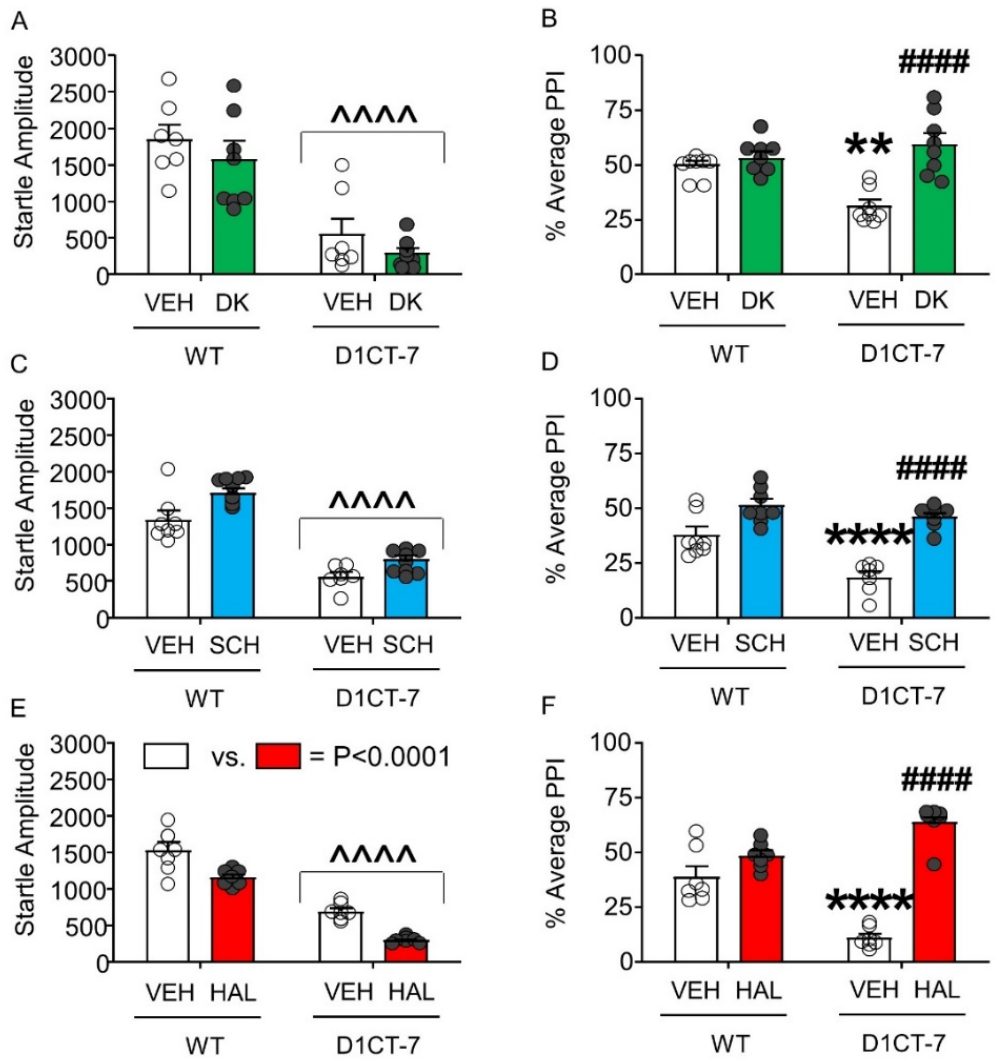
Figure 6. Effects of DK-I-56-1 (DK, 10 mg/kg, IP) and dopaminergic antagonists on tic-like responses in D1CT-7 and wild-type (WT) mice exposed to spatial confinement. ( A ) D1CT-7 mice had lower startle amplitude than WT littermates (Main effect of genotype: F(1,25) = 49.04, p < 0.0001), but this difference was not affected by DK. ( B ) DK reversed the PPI deficits observed in D1CT-7 mice, but not WT mice (Genotype × treatment interaction: F(1,25) = 12.37; p = 0.002). ( C ) The D1 receptor antagonist SCH 23390 (0.5 mg/kg, IP) did not affect startle amplitude. ( D ) SCH 23390 reversed the PPI deficits in D1CT-7 mice (Genotype × treatment interaction: F(1,24) = 5.36; p = 0.03). ( E ) The D2 receptor antagonist haloperidol (HAL, 0.5 mg/kg, IP) reduced startle reflex in both WT and D1CT-7 mice (Main effect of treatment: F(1,24) = 36.64, p < 0.0001). ( F ) HAL reversed the PPI deficits observed in D1CT-7 mice (Genotype × treatment interaction: F(1,24) = 44.99; p < 0.0001). ^^^^ p < 0.0001; main effect of genotype (D1CT-7 vs. WT); ** p < 0.01; **** p < 0.0001 vs. WT mice treated with vehicle (VEH); #### p < 0.0001 vs. D1CT-7 group vehicle-treated. n = 7–8/group. For further details, see text.